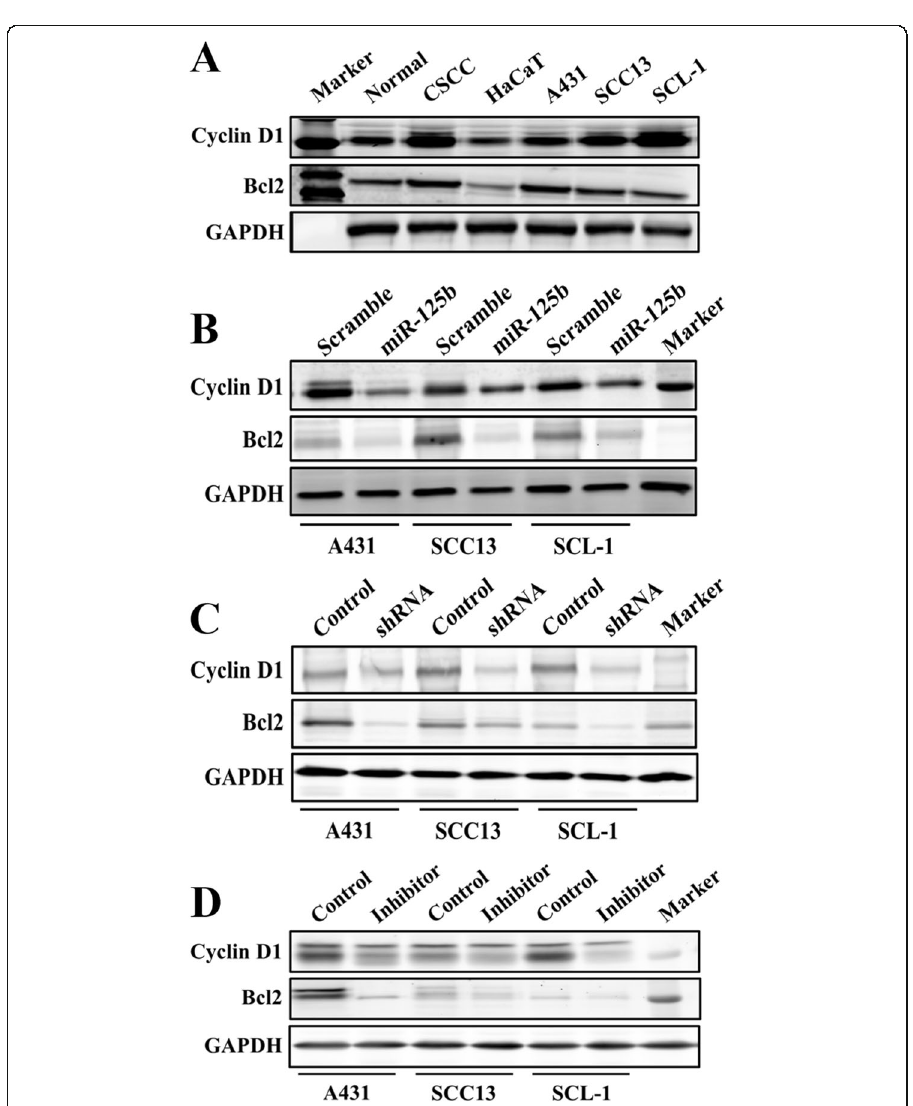
Fig. 5 Cyclin D1 and Bcl2 are the downstream targets of miR-125b/STAT3. a The expressions of cyclin D1 and Bcl2 in CSCC and normal tissues and cells. b , c and d The miR-125 mimic, STAT3 shRNA and inhibitor could inhibit the expression of cyclin D1 and Bcl2 in CSCC